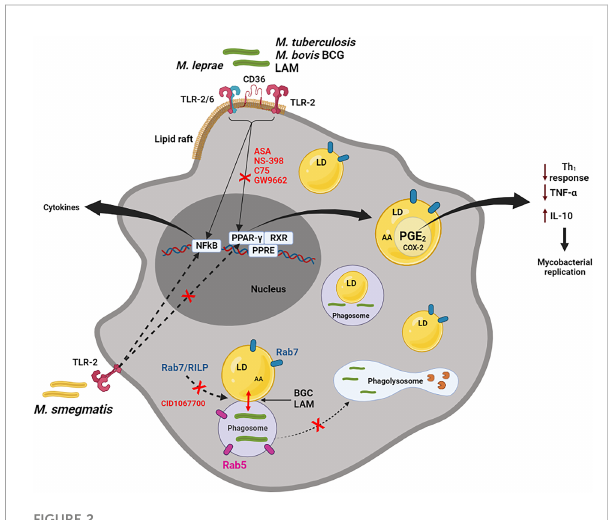
FIGURE 2 Macrophage activation by pathogenic mycobacteria. M. bovis , Mtb , M. leprae and LAM (but not M. smegmatis ) can active macrophages by membrane receptors, such as TLR-2, TLR2/6, CD36 localized in lipid rafts, inducing LDs formation, through PPAR g activation. This pathway can be inhibited by ASA (aspirin), NS-398, C75 and GW9662 (selective PPAR g antagonist). Through NF- k B signaling, pathogenic and non-pathogenic mycobacteria induce the synthesis of cytokines, such as TNF a . LDs, presenting substrate (AA) and enzyme (COX-2), are sites for compartmentalized PGE 2